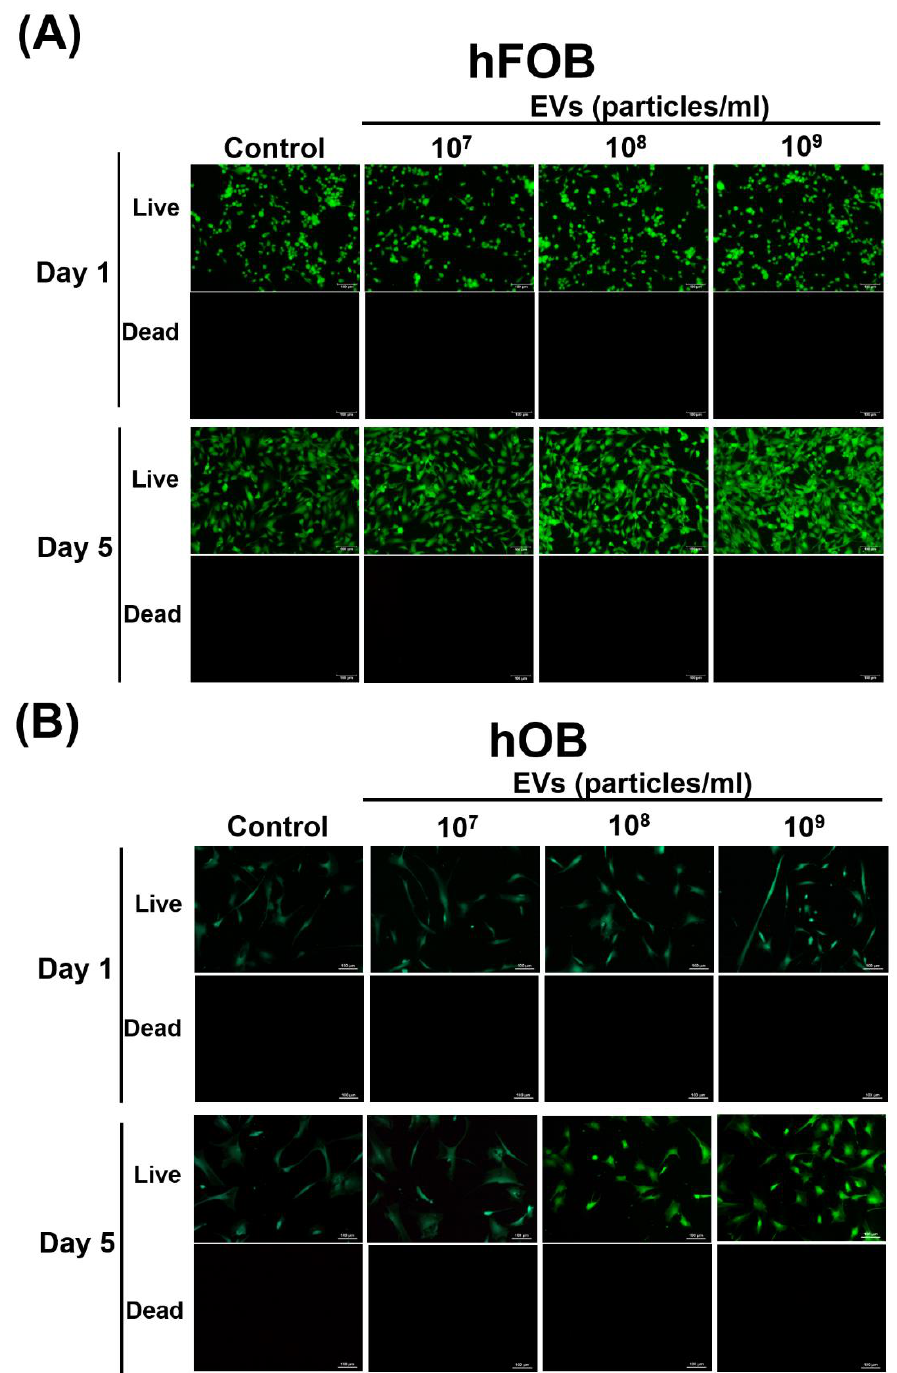
Figure 3. Effect of ADSC-EVs on the survival of osteoblasts. The hFOBs ( A ) and hOBs ( B ) were treated with ADSC-EVs at concentrations of 0 (Control: control group) or 10 9 particles/mL (EVs: EV group) for 5 days and analyzed for survival. Live/dead cell assays were performed for hFOBs and hOBs to determine the cell survival on days 1 and 5. Green fluorescence indicates live cells (Live), whereas red fluorescence indicates dead cells (Dead). The hFOBs and hOBs remained alive on days 1 and 5 after the ADSC-EV treatment.